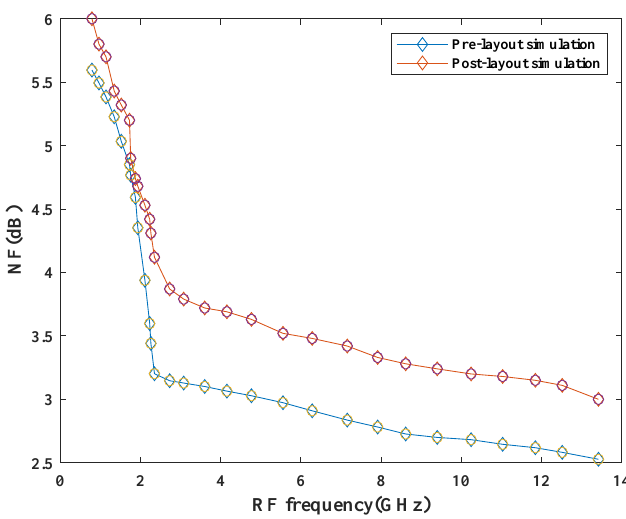
Figure 14. Variation of NF with RF frequency.